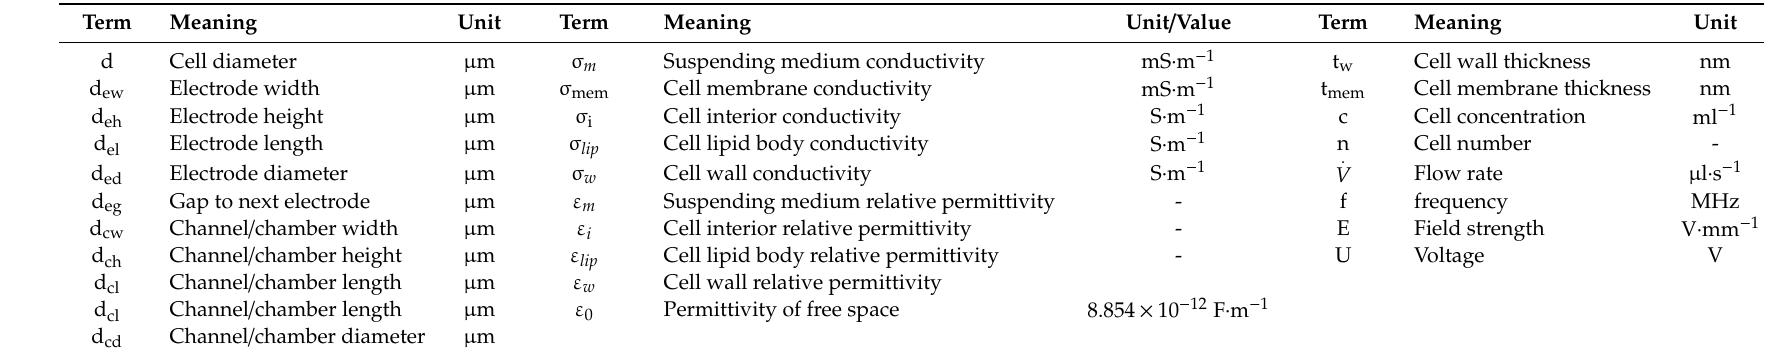
Table 2. Notation and